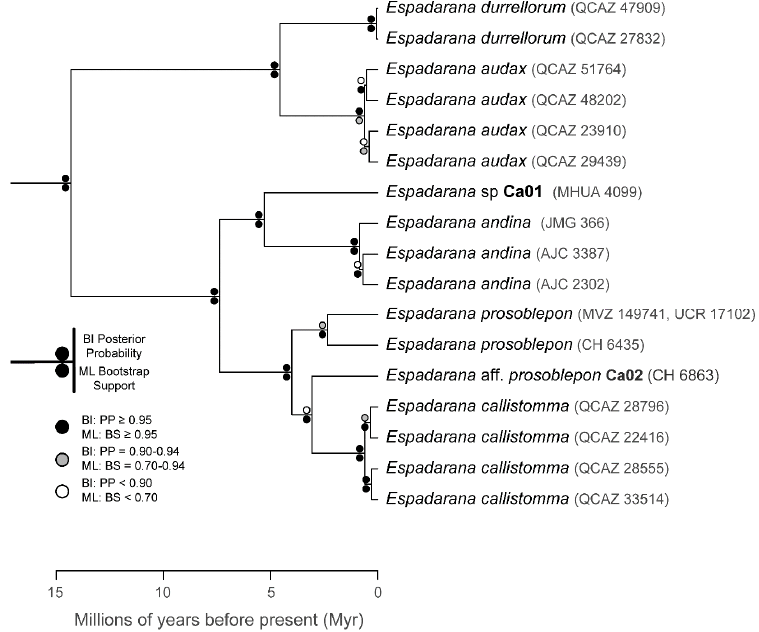
Figure 88. Evolutionary relationships among species in the genus Cochranella , inferred using maximum likelihood and Bayesian criteria.